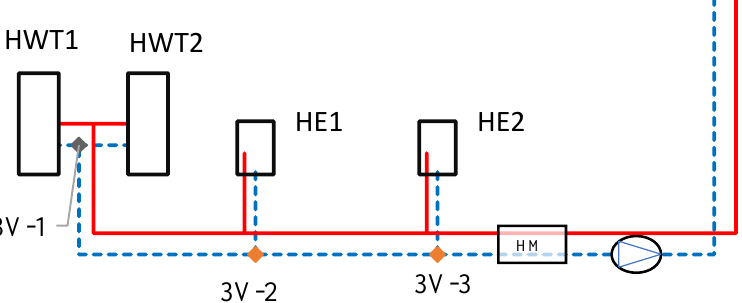
Figure 2. General scheme of the installation in Brzesko (HM—heat meter ( TH 1 and TH 2 temperature and volumetric flow meter included); 3V-1—three-way valve switching storage tank charging; 3V-2 and 3V-3—three-way valve; HWT-1, HWT-2—solar hot water tank; HE1—heat exchanger for sport swimming pool; HE2—heat exchanger for recreational swimming pool). Table 1. Basic parameters of the FPC in the installation in Brzesko and the evacuated tube collector (ETC) in the installation in Krosno. Source: own study based on References [27,44–46]. Parameter Unit Brzesko (FPC) Gross collector area meander with heat